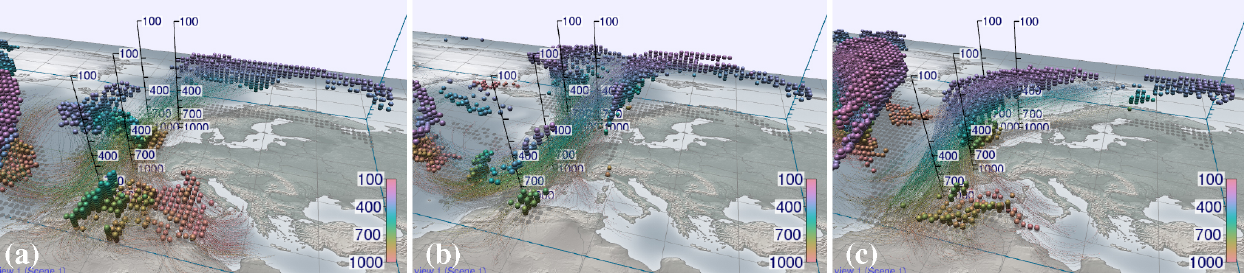
Figure 16. The same as Fig. 15c, but for the ensemble members (a) 2, (b) 9 and (c) 19. Also compare to the visualizations of the corresponding binary grids B shown in Fig.